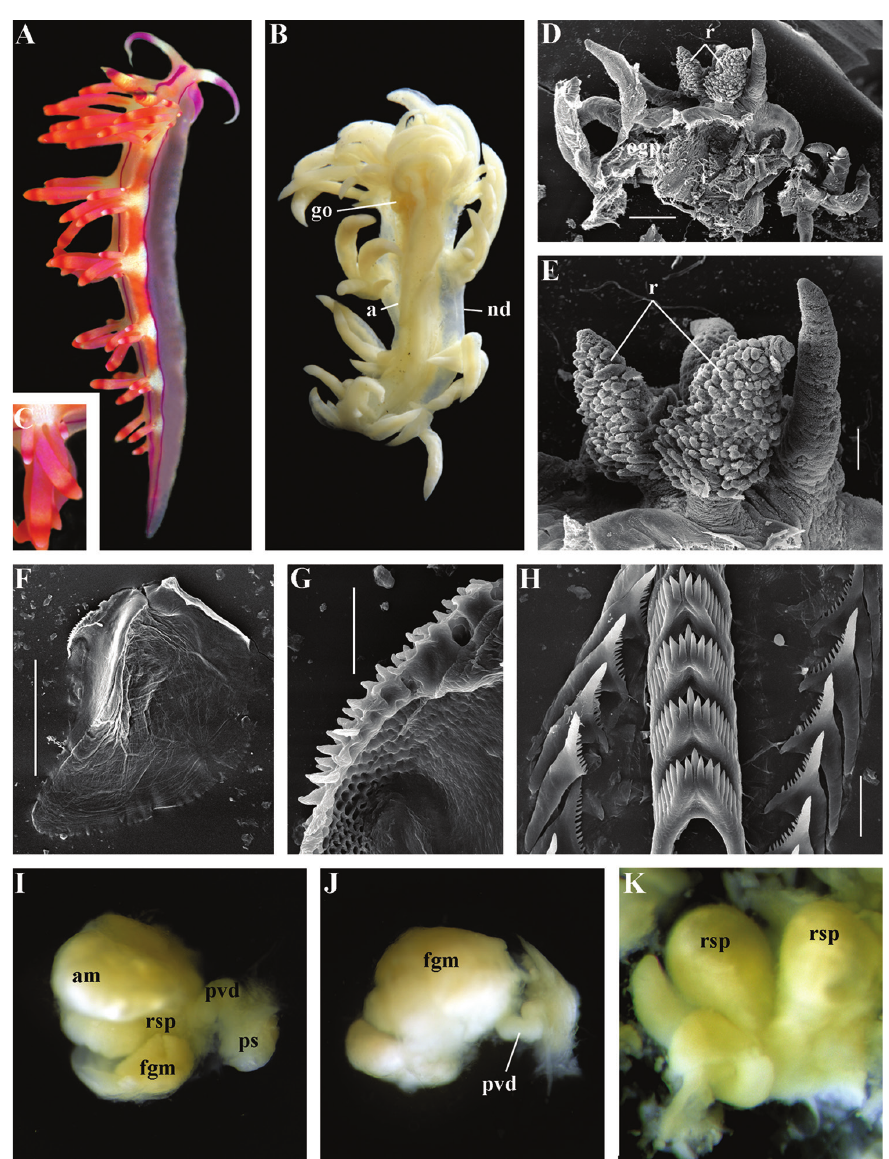
Figure 39. Coryphellina rubrolineata O’Donoghue, 1929. Vietnam, Nhatrang Bay. ZMMU Op-132, living specimen 15 mm in length: A dorsal view B ventral view (fixed) C details of cerata D dissected anterior part (pharynx removed) and rhinophores, SEM, scale bar 1 mm E rhinophores, close up, SEM F jaw, SEM G details of masticatory process of jaw, SEM H radular teeth, posterior part, SEM I, J re- productive system, light microscopy K bilobed proximal receptaculum seminis. Abbreviations: a anus am ampulla fgm female gland mass go genital opening nd discontinuous notal edge ogp oral gland penetrating into basis of cerata ps penial sheath rsp proximal receptaculum seminis pvd prostatic vas deferens r rhinophores. Scale bars: D, F = 300 μm; G, H = 30 μm. Photos of living specimens by O.V. Savinkin, other photos and SEM images by A.V.